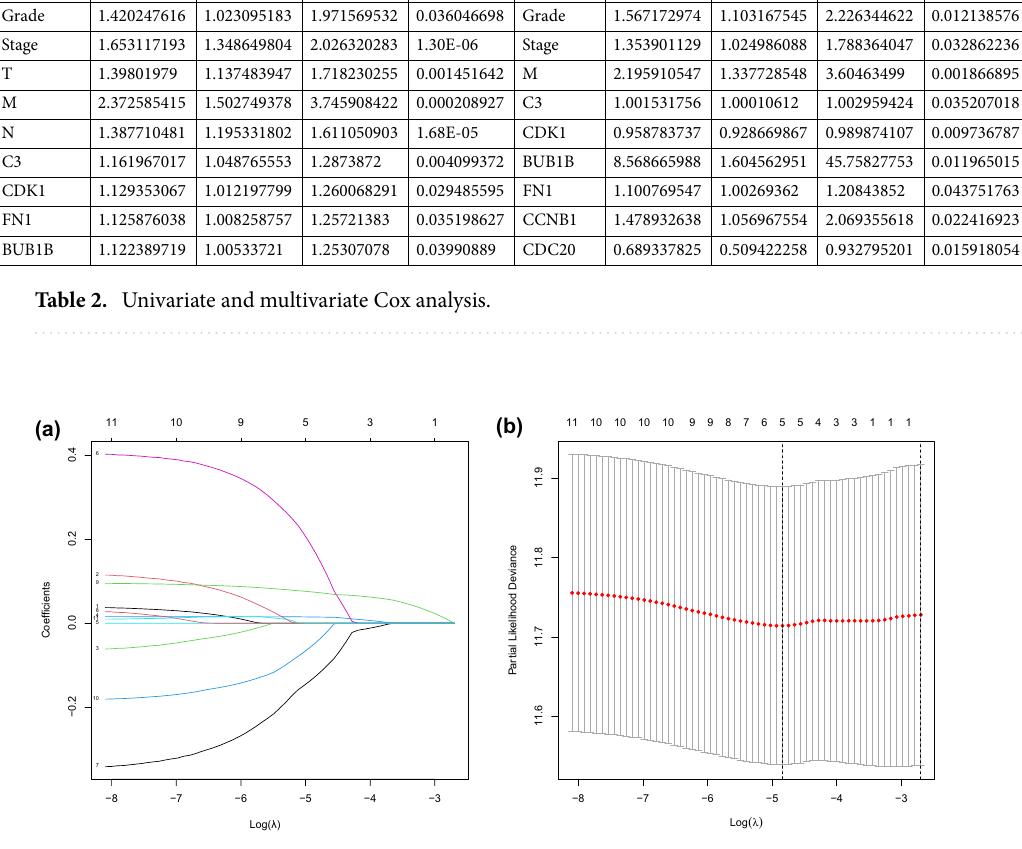
Figure 7. LASSO regression model analysis. ( a ) is the path change chart of regression coefficient and ( b ) is the change curve of penalty term. [The figure was created by R version 3.5.1 (https ://www.r-proje